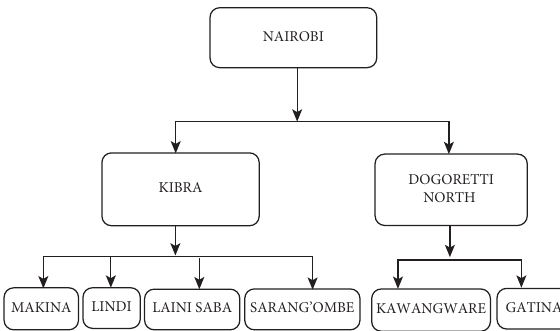
Figure 2: A flow diagram illustrating the sampling frame.